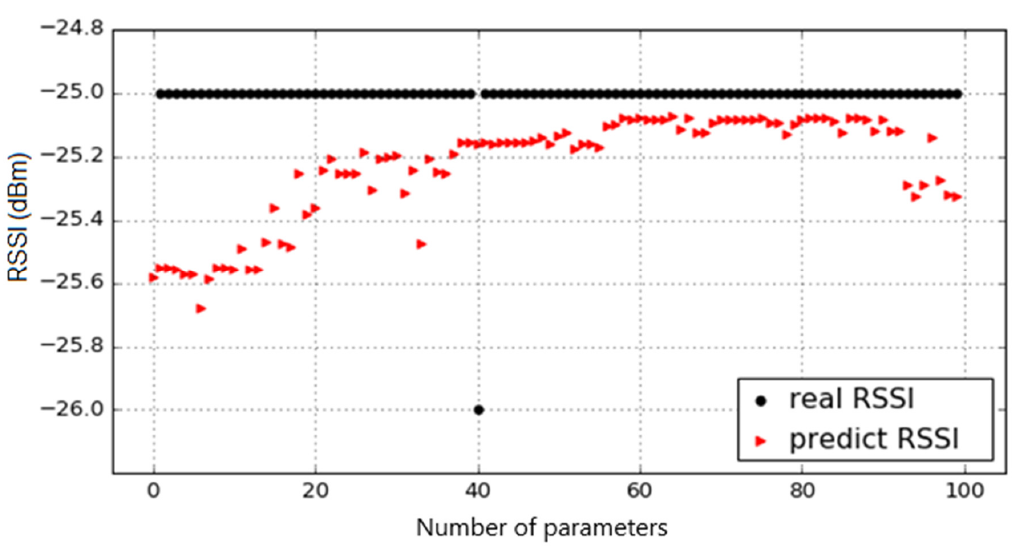
Figure 10. Example of prediction using gradient-boosting regressor.